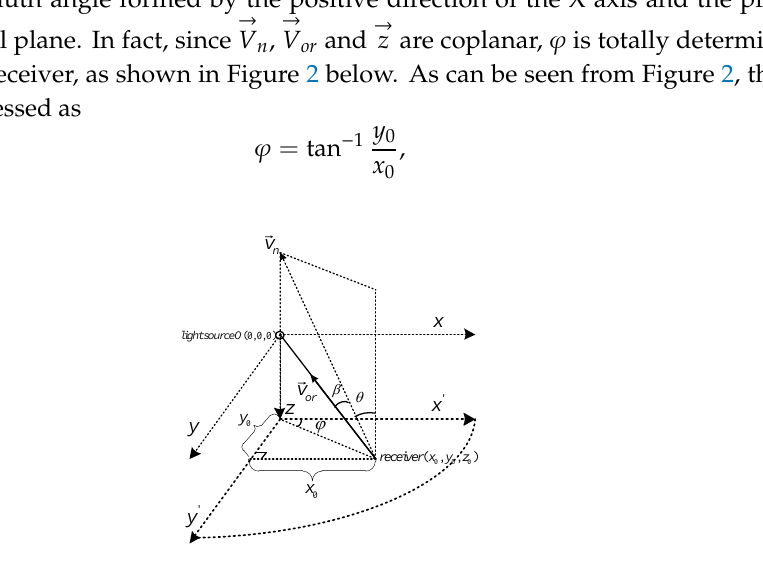
Figure 2. Projection of